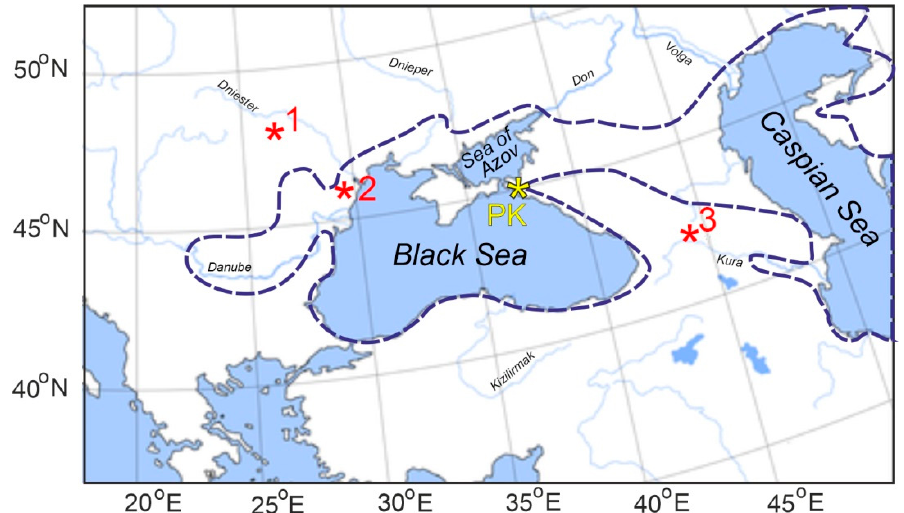
Figure 3. Locations of the Popov Kamen section (PK, yellow asterisk) and coeval fossils of Juniperus from the regions adjacent to the Black Sea (red asterisks). The Paratethys area configuration at the Late Miocene is marked by dotted line. 1: The cone of Juniperus bessarabica Negru from the lower Sarmatian of Moldova [14]. 2: Pollen of Juniperus sp. from the lower Maeotian of southern Ukraine [33]. 3: Pollen of Juniperus sp. from the Sarmatian of eastern Georgia [34].